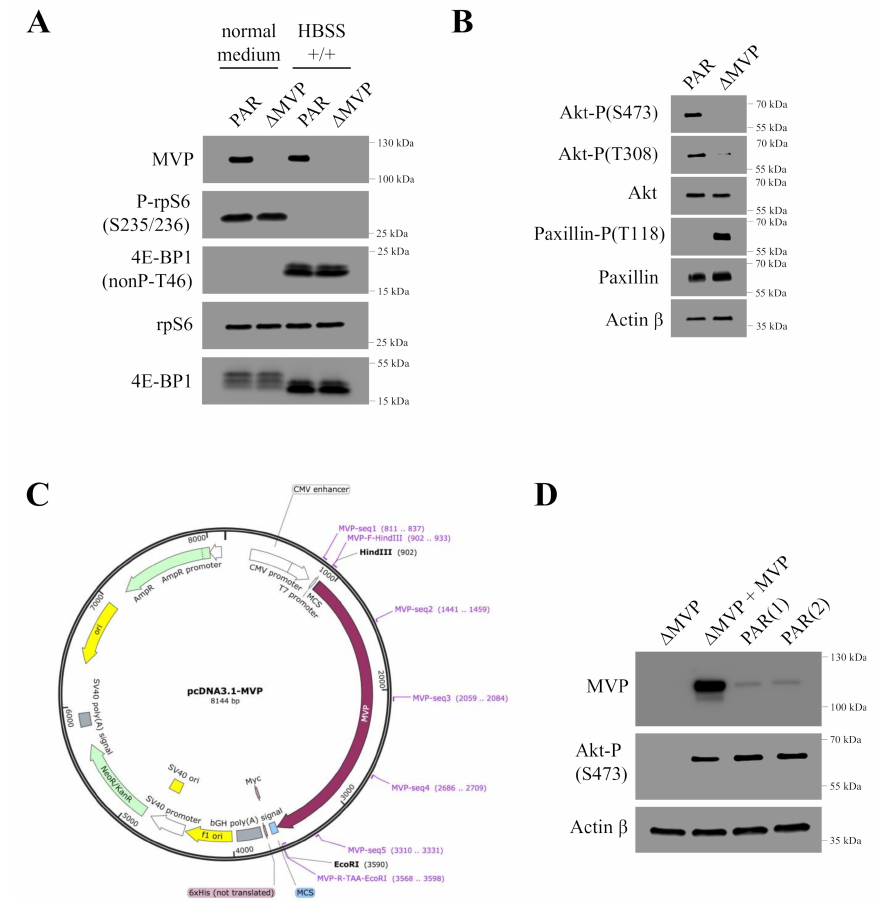
Figure 6. Analysis of PI3K/mTOR/AKT pathway activity in U2OS parental cells and MVP-negative cells (U2OS- ∆ MVP, clone c5). ( A ) Analysis of the phosphorylation of proteins related to mTORC1 activity in U2OS parental cells and MVP negative cells (U2OS- ∆ MVP). Additionally, starvation conditions were used using HBSS +/+ buffer. ( B ) Analysis of the activity of the Akt protein and paxillin in U2OS and U2OS- ∆ MVP cells. ( C ) Map of the expression plasmid containing the sequence of the human MVP. ( D ) Analysis of Akt protein phosphorylation in MVP knockout cells, in cells transfected with the plasmid forming the exogenous MVP, and in U2OS parental